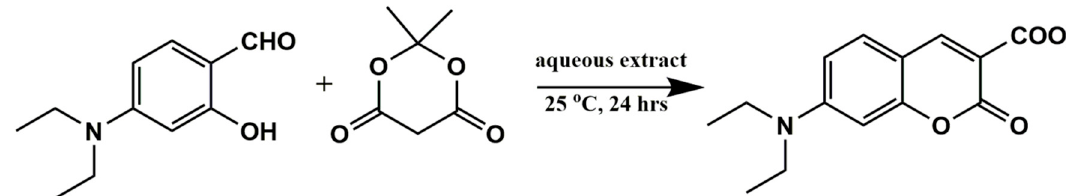
Figure 4. Aqueous berries extract-mediated synthesis of the fluorescent probe 7-DCCA.